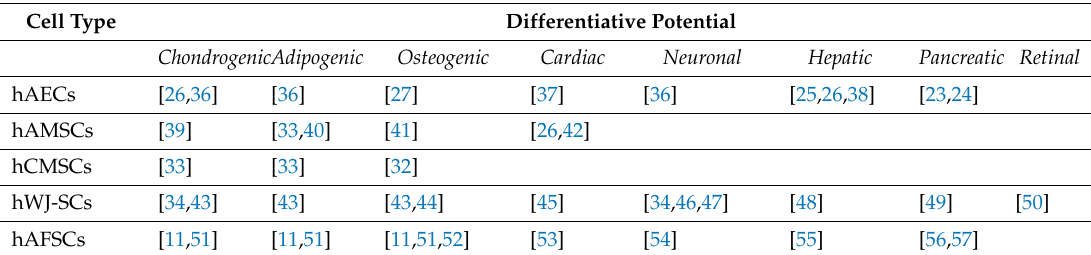
Table 2. Differentiative potential of fetal annex-derived stem cells.